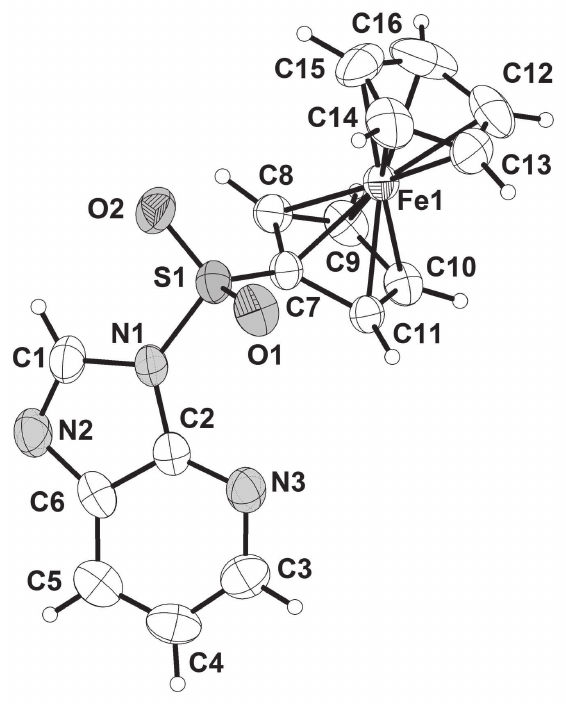
Table 1: Data collection and